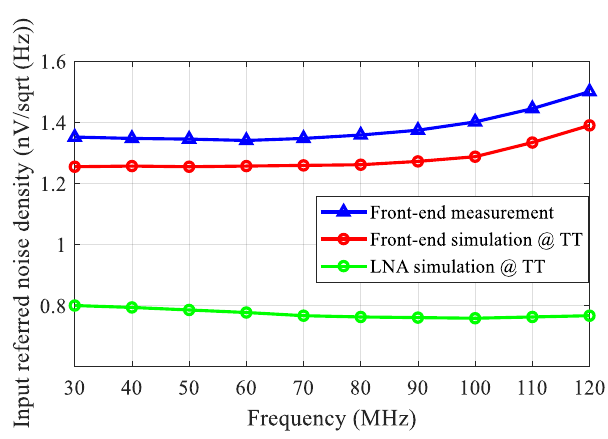
Figure 19. The measured input-referred noise density of the front-end.